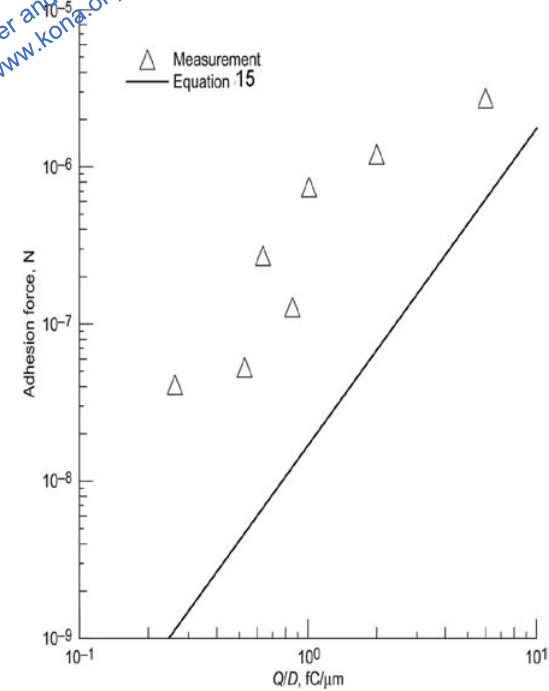
Fig. 2 Toner adhesion forces obtained from centrifuge measurements compared with image force model calculations (Eqn. 15 with s ≈ 0, which assumes charge is distributed uniformly over the particle’s surface) as a function of the average toner charge-to-diameter ra- tio [Hays,